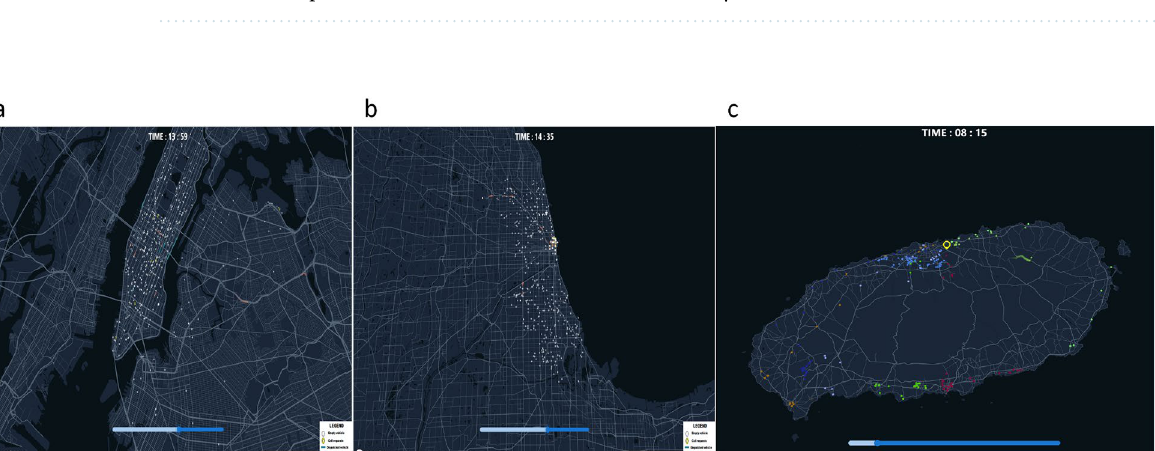
Table 4. The implementation of DTUMOS for various mobility services in various cities.